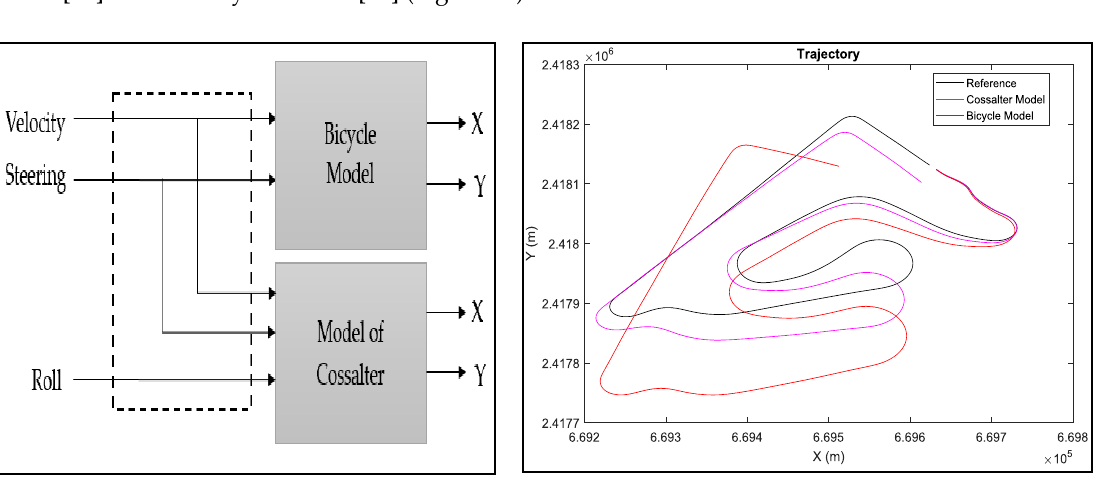
Figure 10. Trajectory reconstruction from kinematic models.